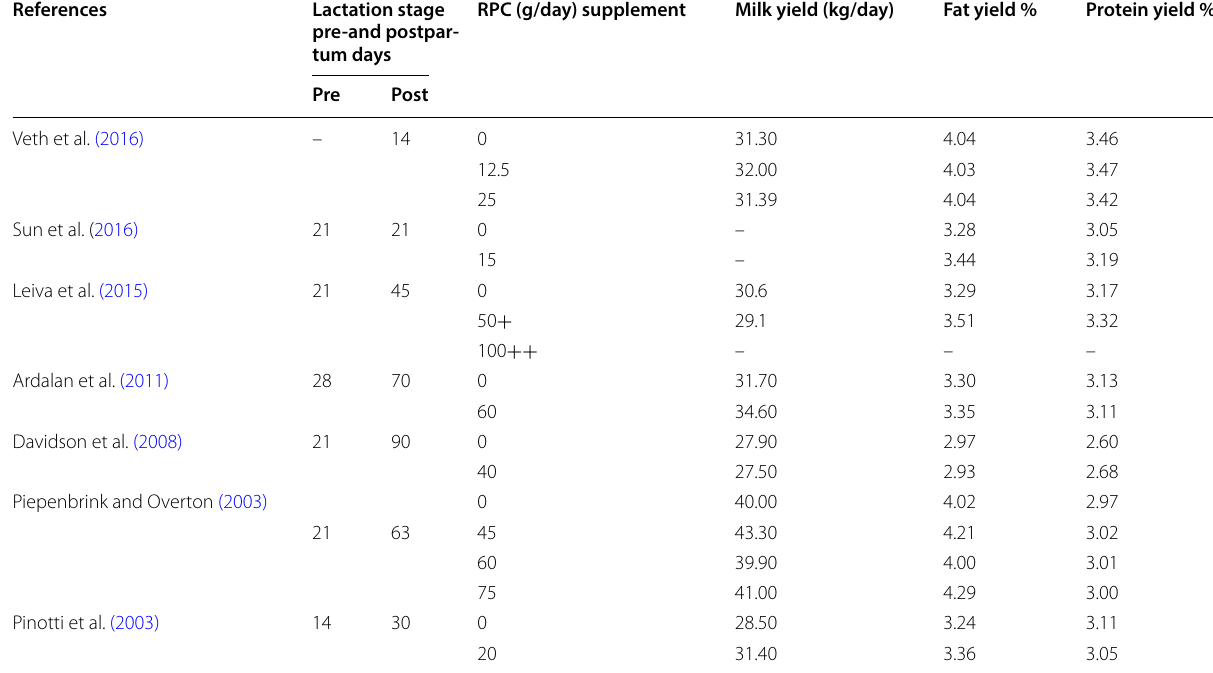
–, not reported; , supplemented before calving; +